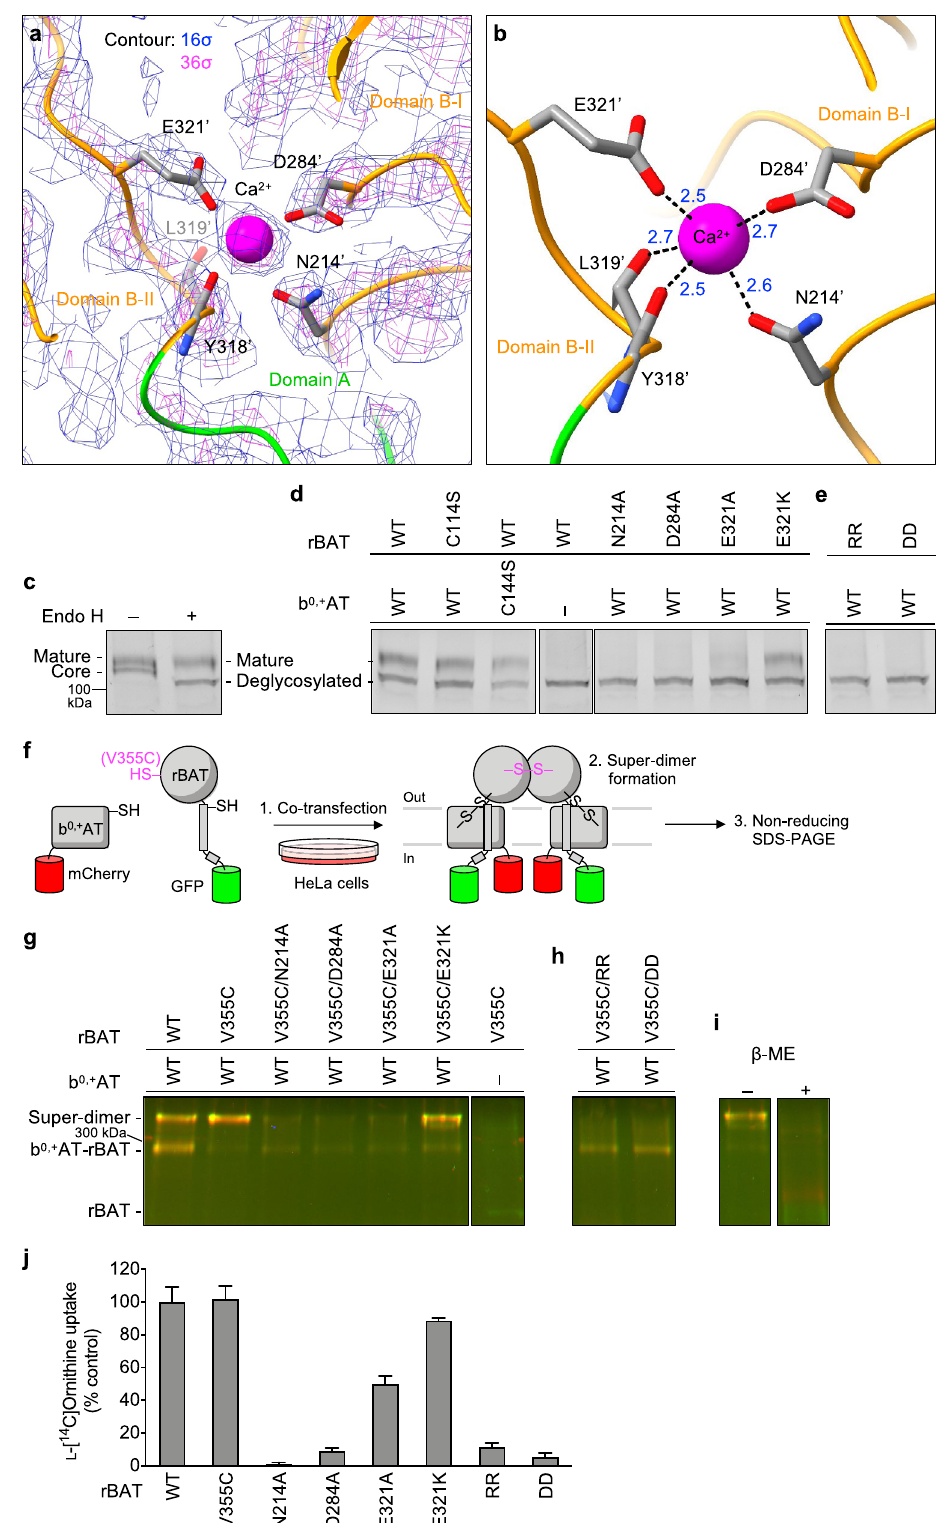
(Supplementary Fig. 9a,b). As a positive control, co-expression of fl uorescence-tagged wild-type rBAT and b 0, + AT yielded an Endo H-resistant rBAT band (Fig. 5c). By contrast, rBAT alone did not mature in the absence of b 0, + AT (Fig. 5d: lane 4), con- fi rming the requirement of b 0, + AT for rBAT maturation 12 . Using this assay, we investigated the effects of the Ca 2 + -binding